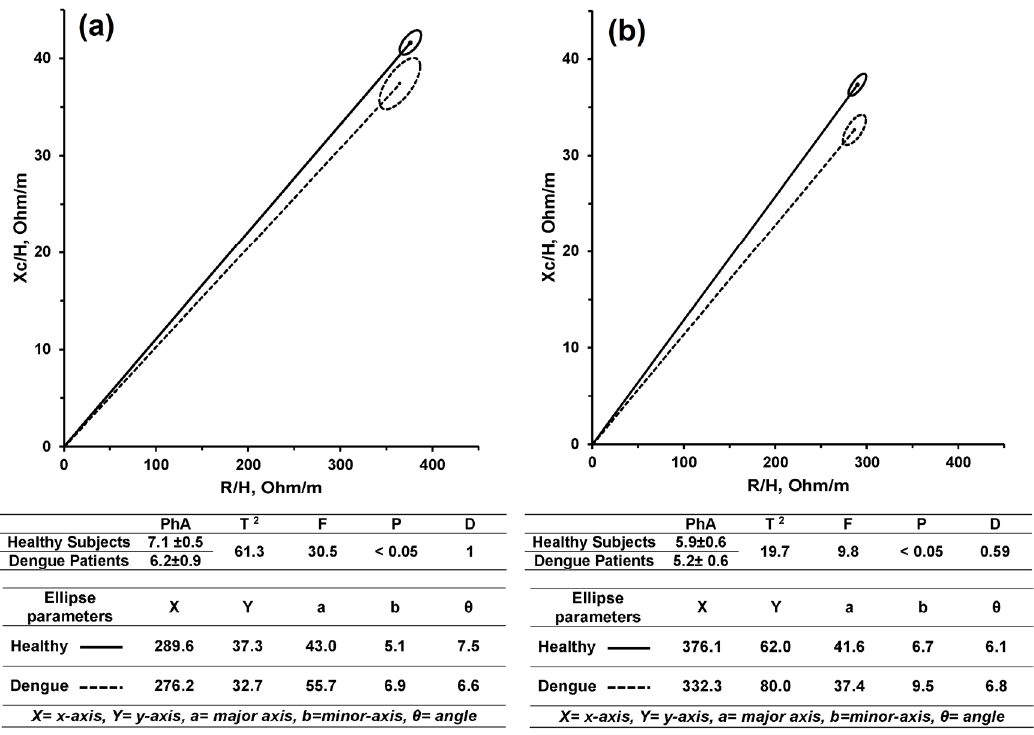
Figure 2. The 95% confidence ellipses for healthy (solid) and Dengue-infected (dashed) subjects: ( a ) Males; ( b ) Females. Table 2. Demographic and BIVA parameters for severe and non-severe Dengue subjects. ( p -Value less than 0.05). Dengue ANOVA Test Student t Test Non-Severe Severe Groups F p -Value T p